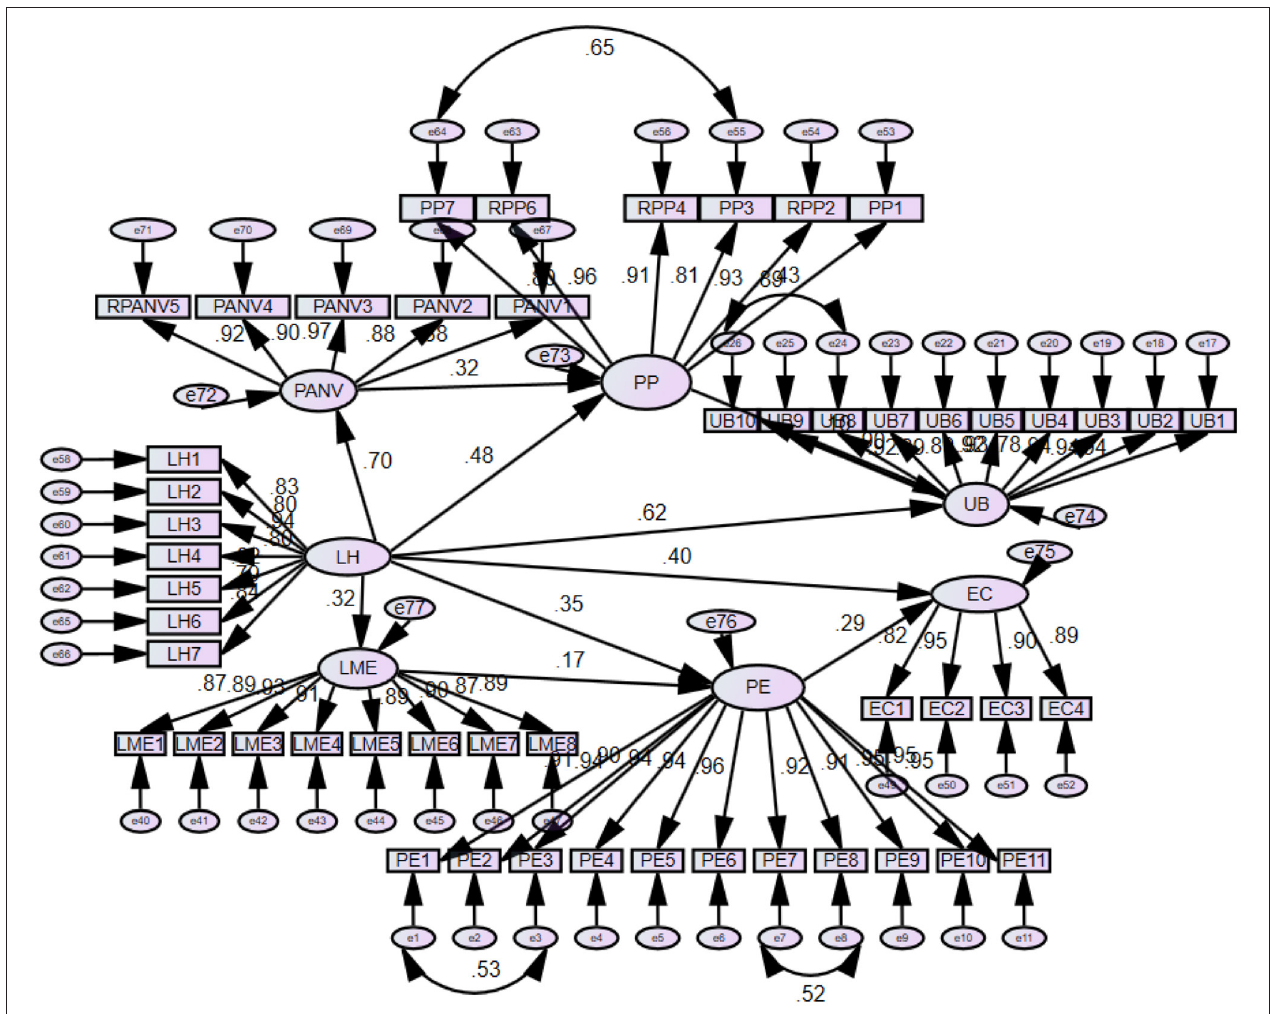
FIGURE 3 | Structural